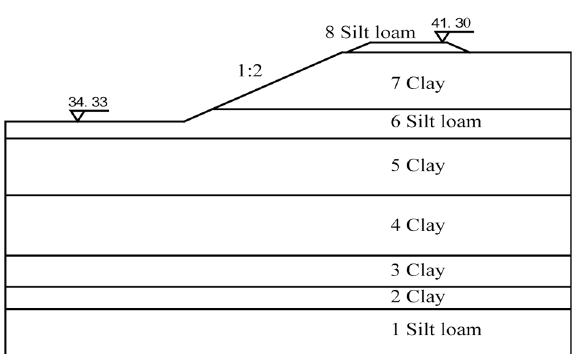
Fig. 4. Geometry and Soil layer distributions of slope K2+300 (m)